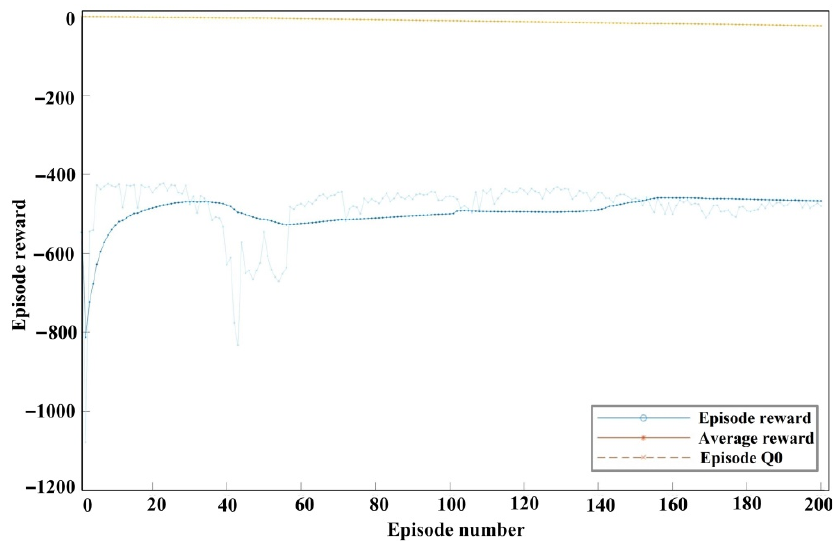
Figure 24. The training stage of the RL-TD3 agent for the correction of the u dref and u qref commands.